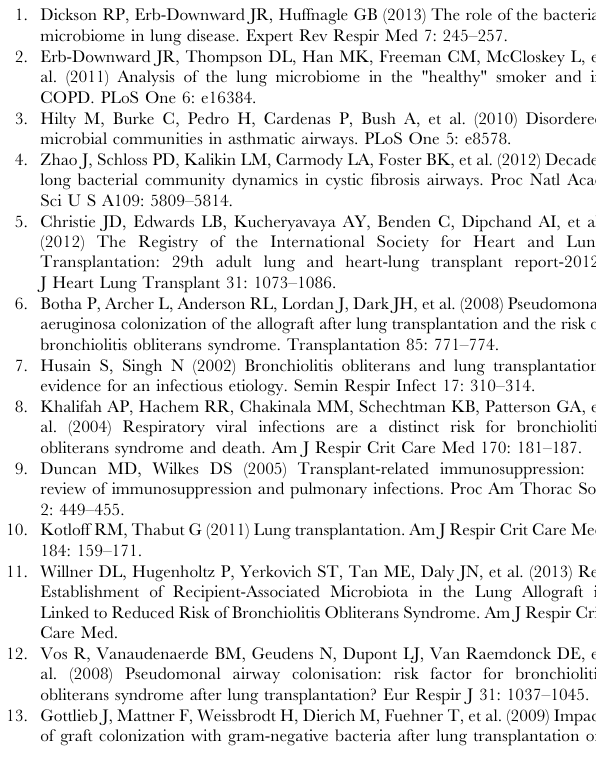
Figure S2 Genomic Comparison of Prominent Pseudo-